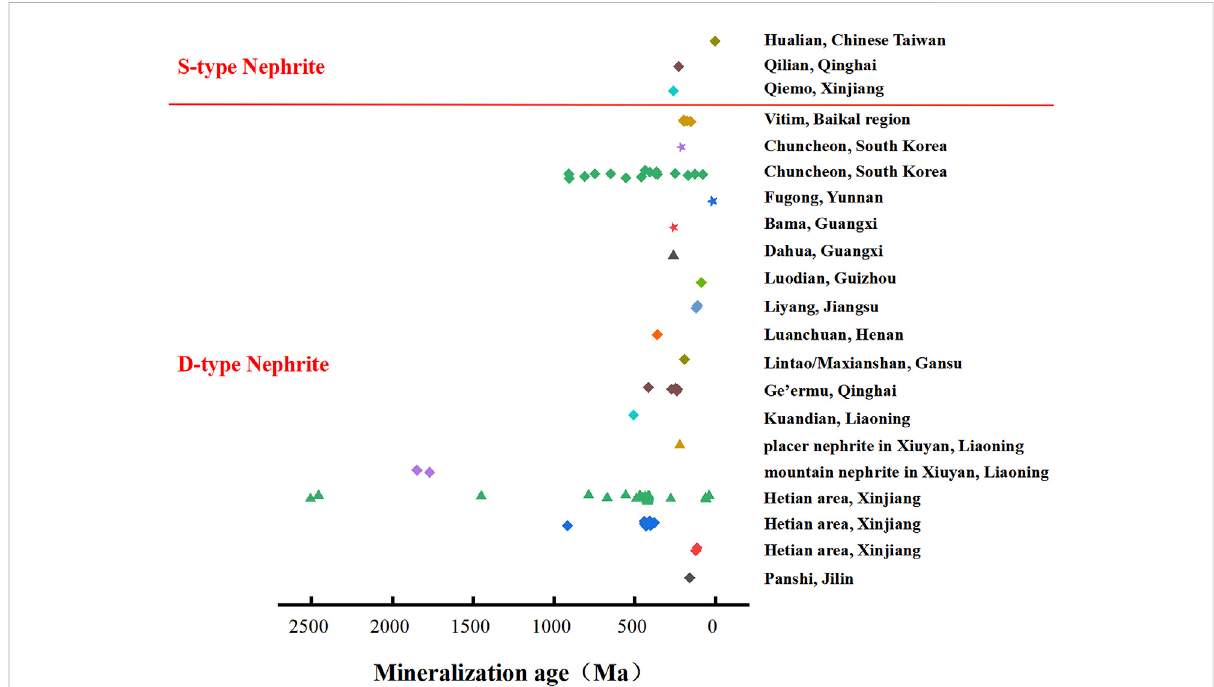
FIGURE 2 MineralizationagesofnephritedepositsinChina,SouthKoreanPeninsulaandBaikalregion.( ◆ meansmineralizationagesofnephrite; ▲ means the upper limit of mineralization ages of the nephrite; + means presumed ages of nephrite mineralization. The differences of ages are caused by different tested subject and dating methods, which can be seen in TABLE